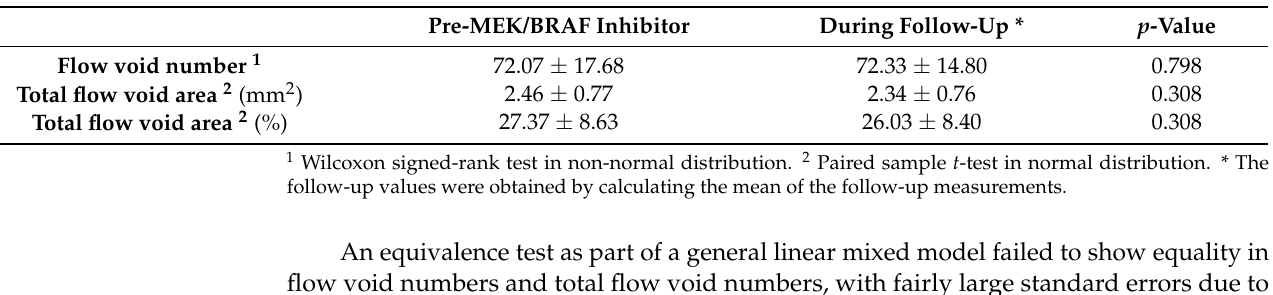
Table 3. Comparison of choriocapillaris flow void parameters before initiation of treatment and during